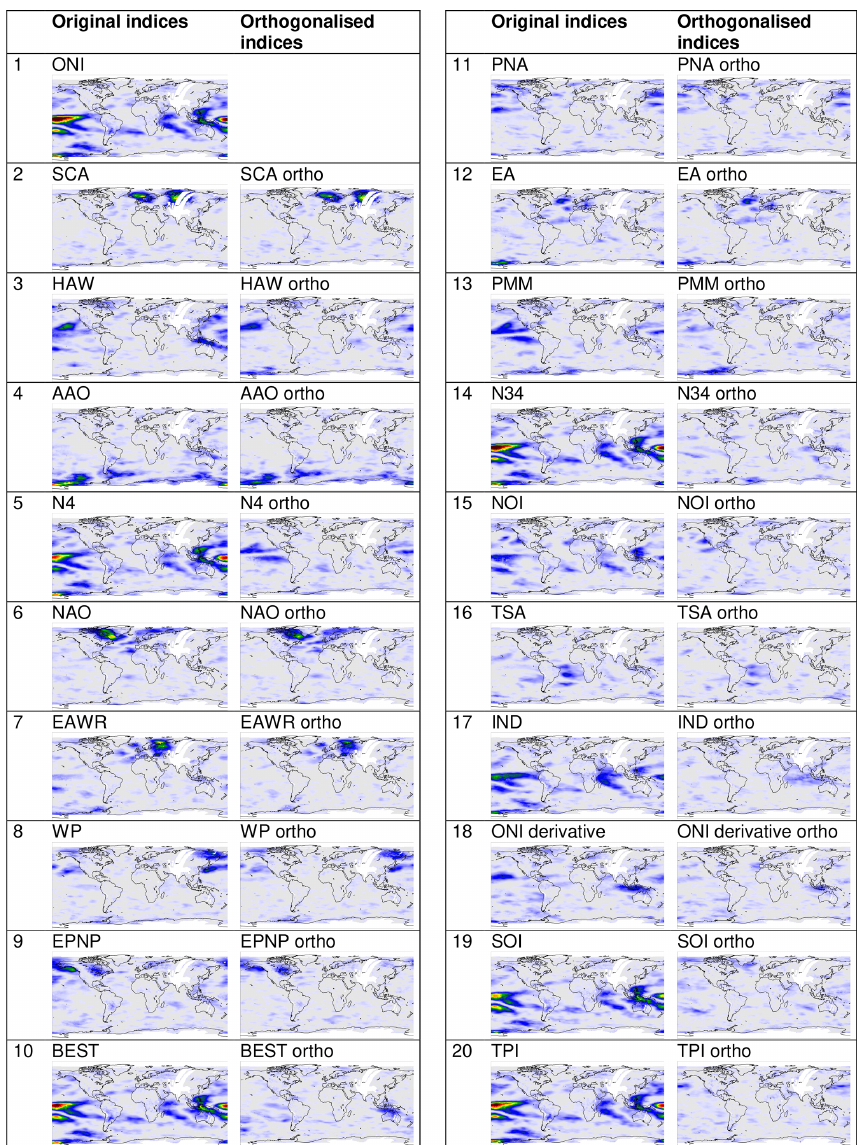
Figure A12. Delta rms maps for the significant orthogonalised indices together with the delta rms maps for the original indices. The numbers at the left sides indicate the order (descending) of the p99 values (see also Fig.